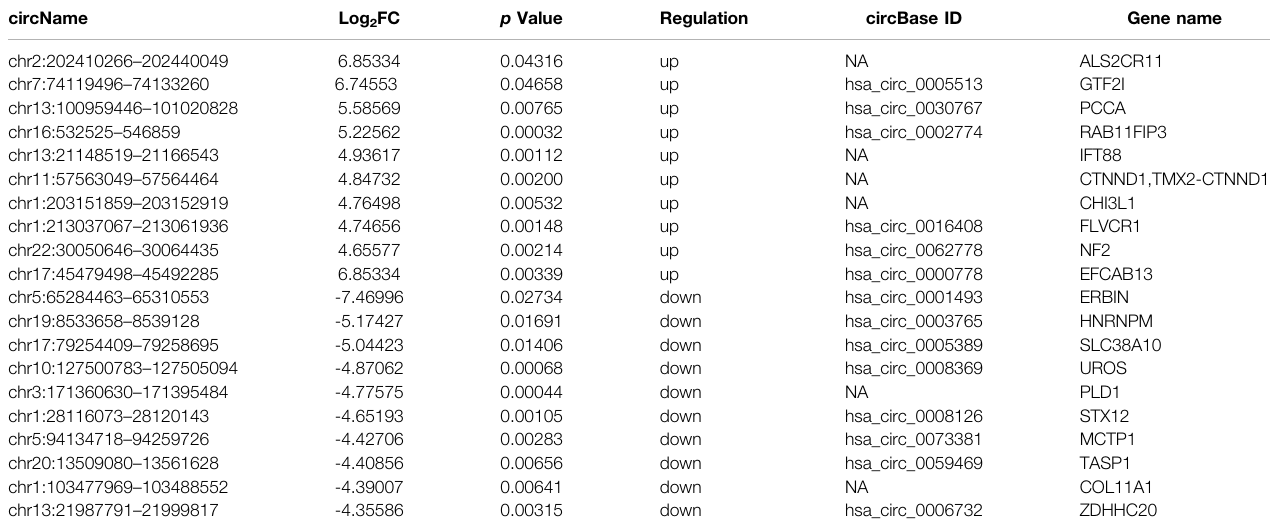
TABLE 1 | Top 20 dysregulated circRNAs in AS-BMSCs compared with HD-BMSCs. circName Log 2 FC p